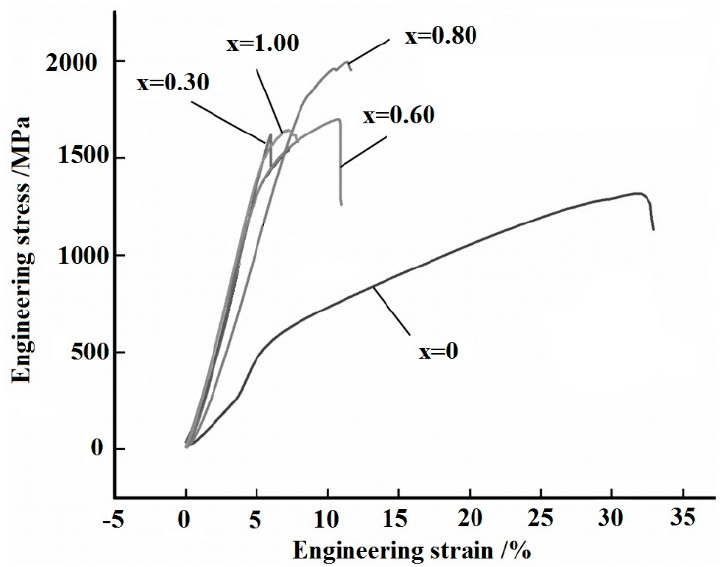
Figure 11. Compressive stress-strain curve at room temperature of the specimen after corrosion.